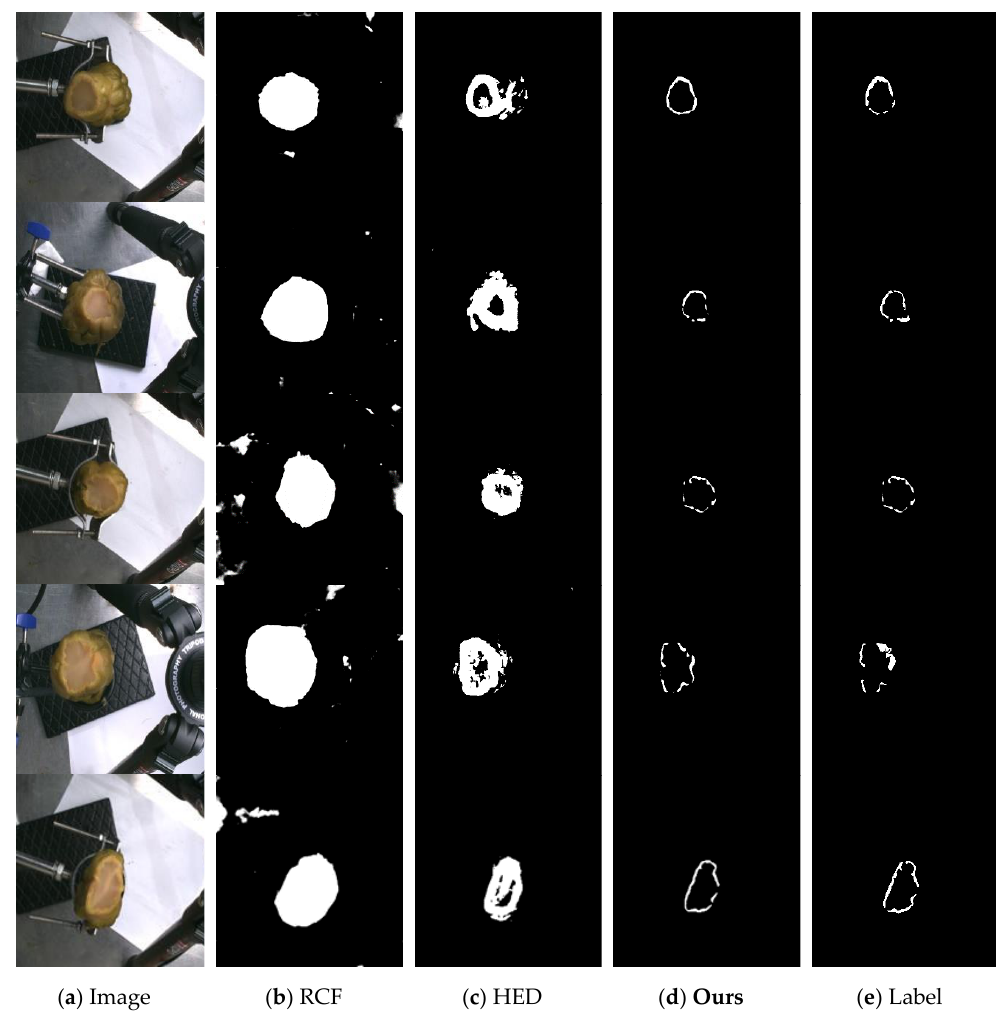
Figure 4. Comparison of richer convolutional features for edge detection (RCF), holistically-nested edge detection (HED) and dilated-HED. From left to right: ( a ) original images; ( b ) the results of RCF; ( c ) the results of HED; ( d ) the results of our method; ( e ) labels, also known as ground-truth.